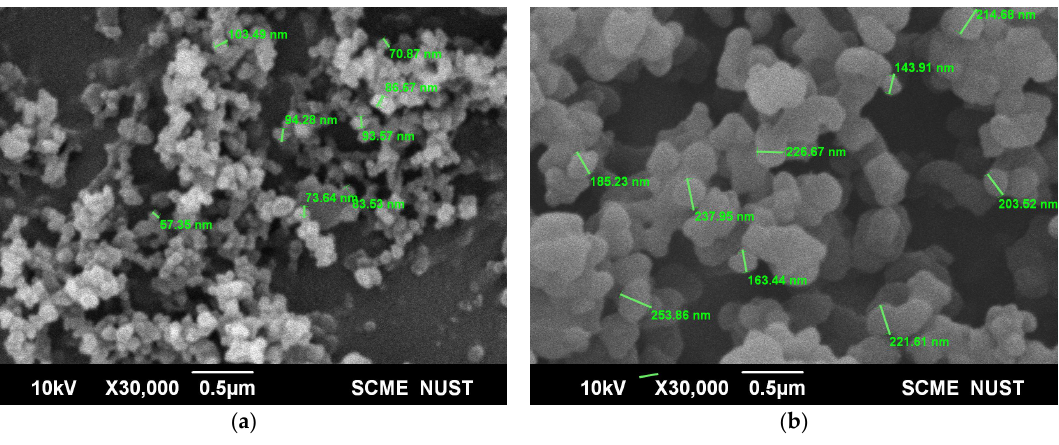
Figure 1. SEM images of ( a ) MMIPs ( b ) MNIPs.